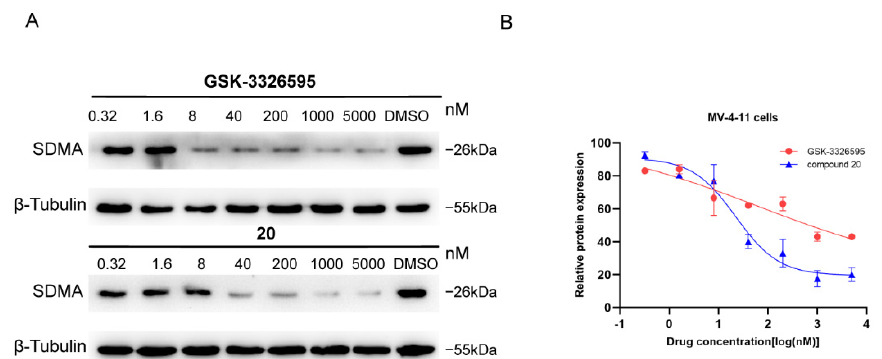
Figure 5. ( A ) Effect of diluent of GSK-3326595 and compound 20 by five-fold concentration gradient protein expression of MV-4-11 cancer cells. Western blot analysis of PRMT5 substrate sDMA, as indicated in MV-4-11 cancer cells treated with the indicated compounds for 96 h. β -Tubulin was used as a loading control. ( B ) The relative strength of sDMA signal on the Western blots was measured by densitometry. The data are shown as the mean ± SD of three independent experiments.